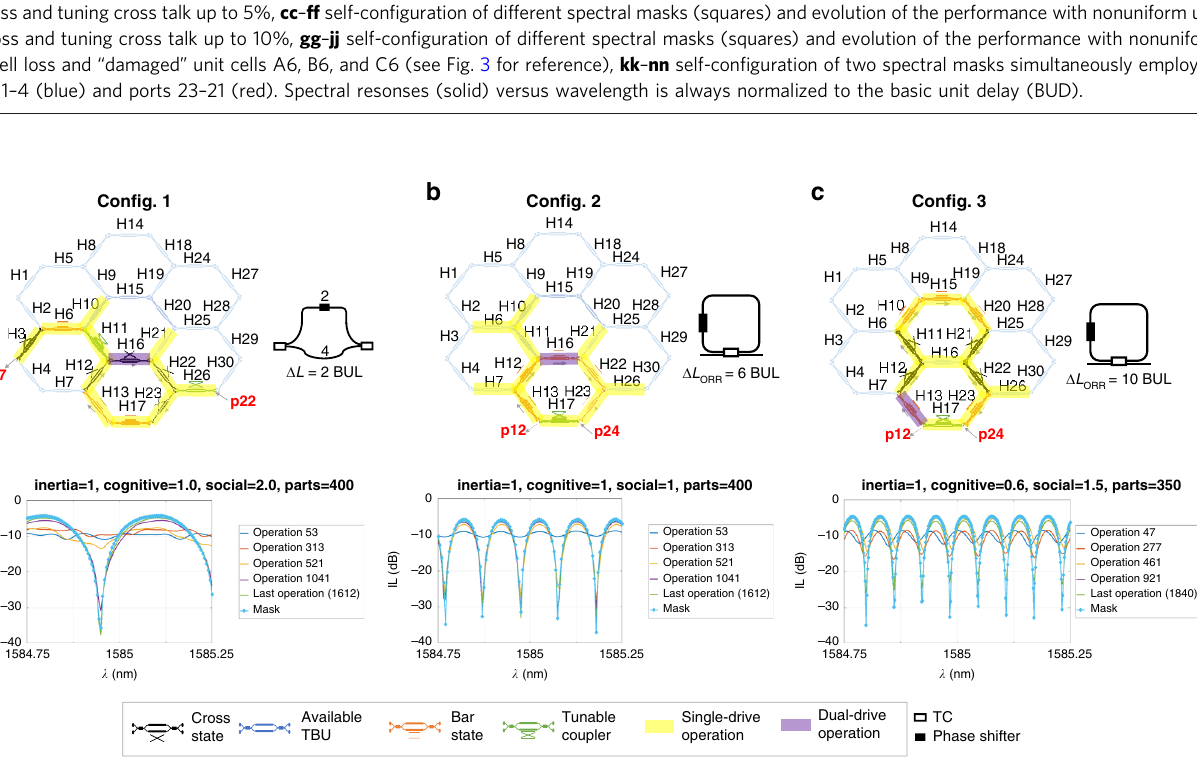
Fig. 5 Experimental realizations of several interferometric circuits in a waveguide mesh using particle swarm optimization algorithm. a Labeled schematic of the electrically driven units for a targeted 2-Tunable Basic Unit (TBU) imbalanced Mach – Zehnder interferometer (MZI) and evolution of the spectral traces employing 101 points for a set of selected operations. b Labeled schematic of the electrically driven units, for a targeted 6-TBU optical ring resonator (ORR) response and evolution of the spectral traces employing 301 points for a set of selected operations. c Labeled schematic of the electrically driven units, for a targeted 10-TBU ORR and evolution of the spectral traces employing 501 points for a set of selected operations. The average MSE obtained for each of these con fi gurations after the end of the process were of 0.542, 0.702, and 4.139, with ER of around 25 dB for the 2-TBU MZI and the 6-TBU ORR, and 20 dB for the 10-TBU ORR. The overall number of operations in each experiment was of 1612 for a and b , and 1840 for c